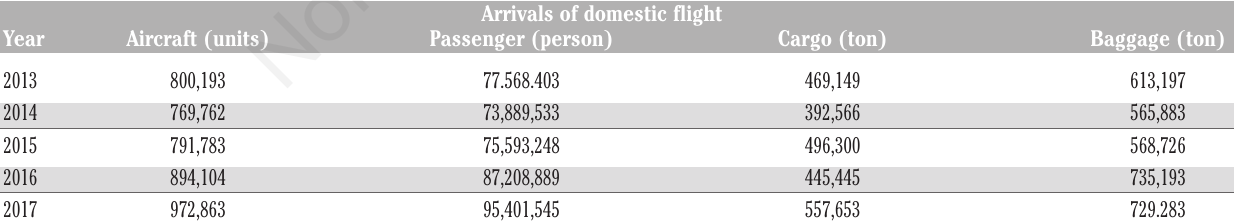
Arrivals of domestic flight